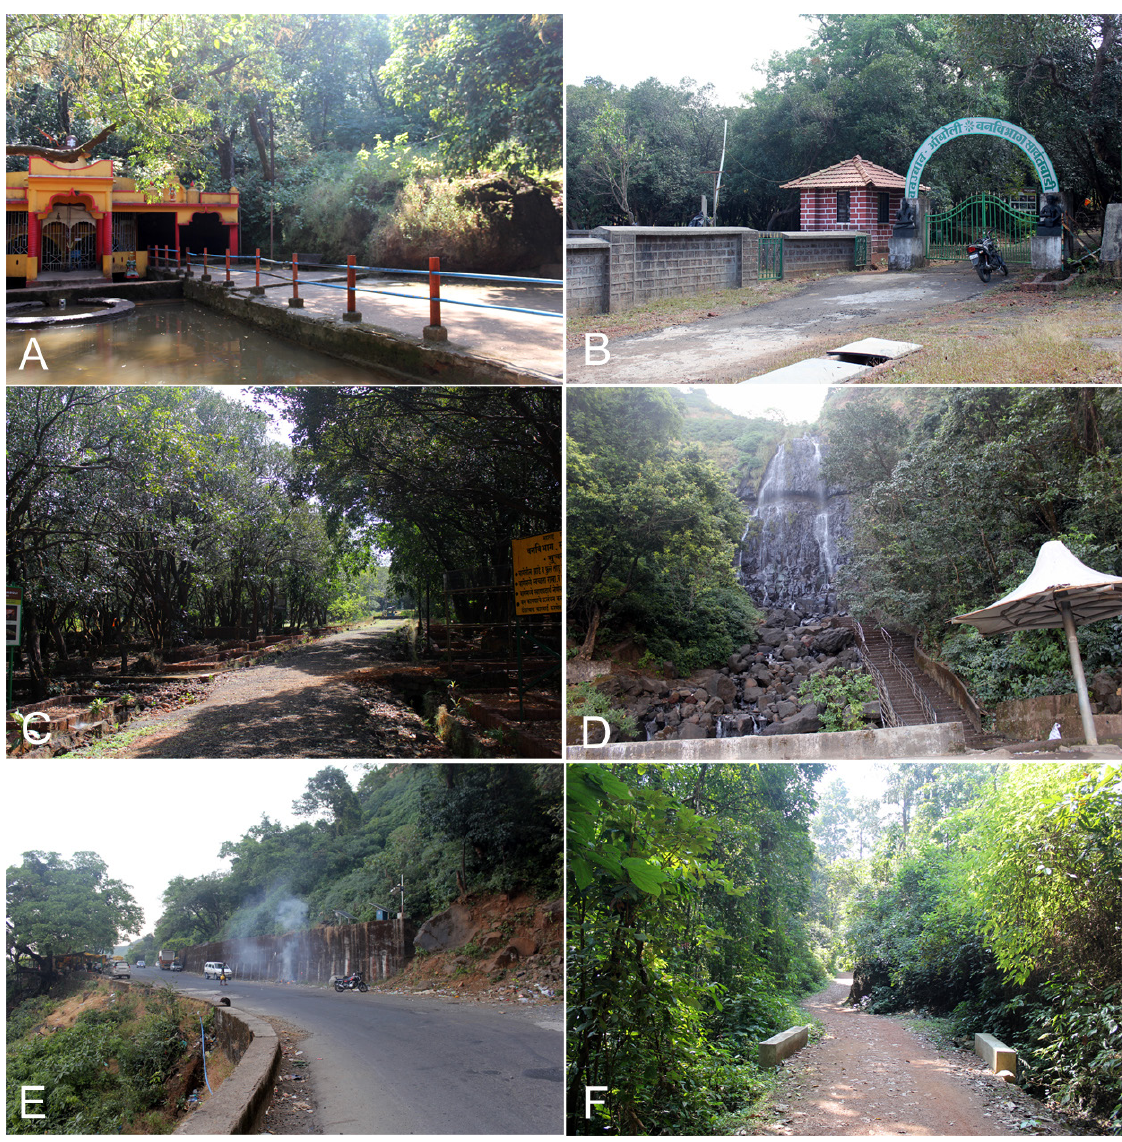
Fig. 13. Habitat of Varadia amboliensis Bhosale, Thackeray, Muley & Raheem gen. et sp. nov. A . Hiranyakeshi temple. B–C . Amboli Forest Park; snails were observed on the walls of the temple and other structures and in the surrounding forest. D–E . Amboli waterfall; snails were observed on the wall near the sunshade (D) and on the roadside safety barrier (E). F . Yana Forest, where snails were found on the forest floor, close to the